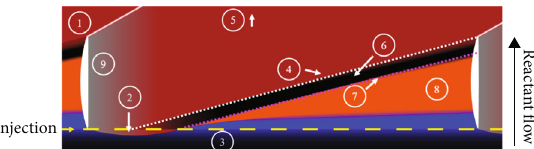
Figure 9: Schematic of a non-premixed RDE fl ow fi eld under partial vitiation operation